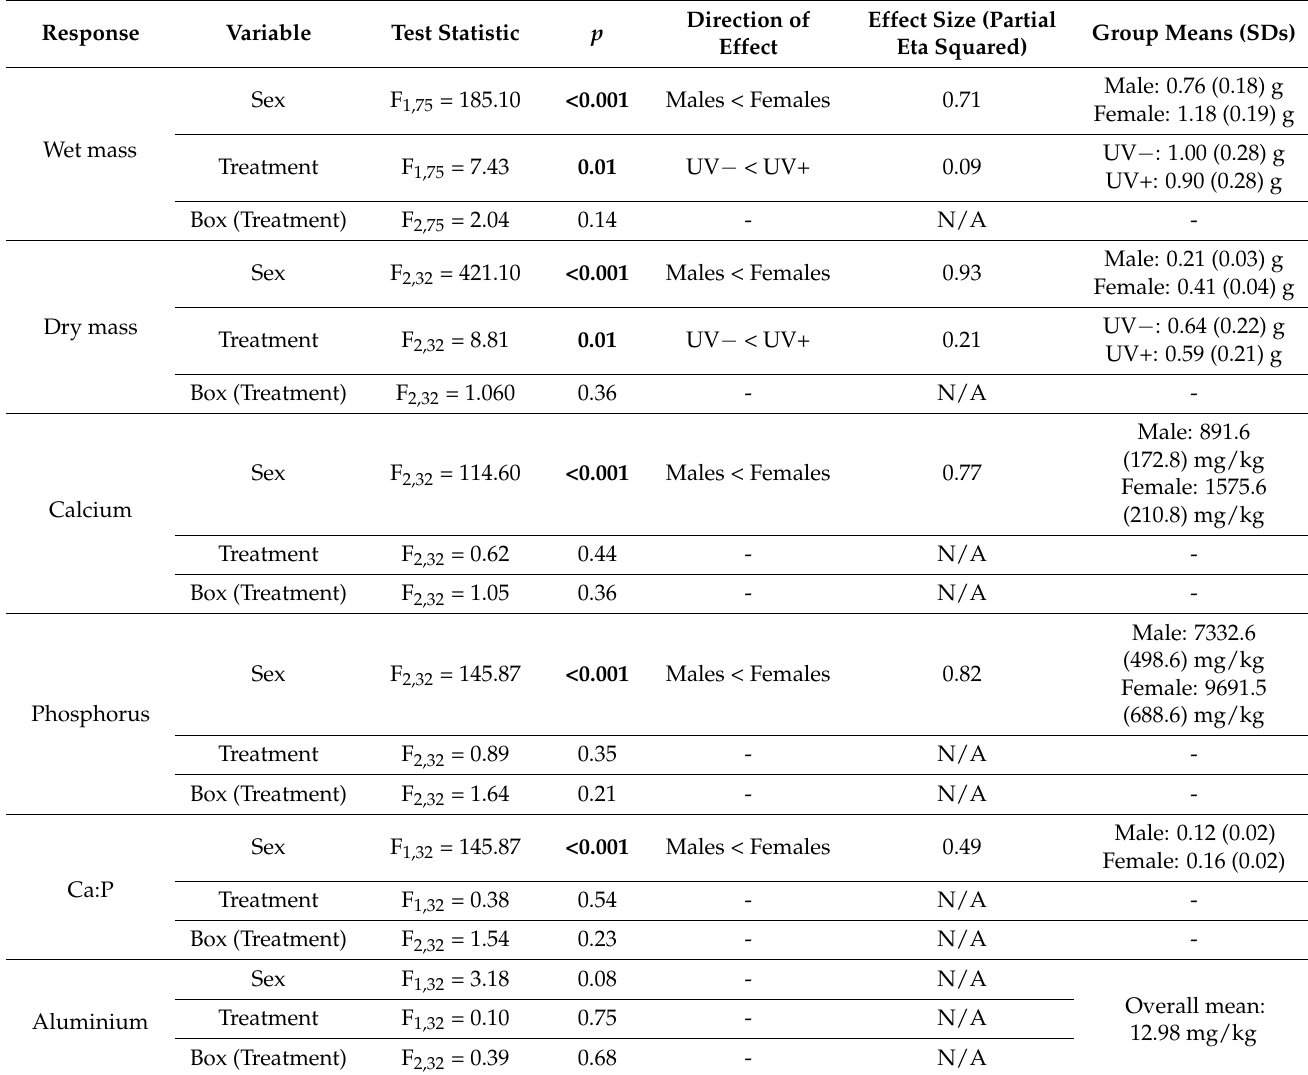
Table 2. Statistical outcomes of ANOVAs testing for the effects of UV treatment, sex and box (treatment) on the dry mass, wet mass, mineral content and Ca:P ratios of crickets. Significant p values are in bold; all remained significant after correcting for False Discovery Rate (adjusted p values not